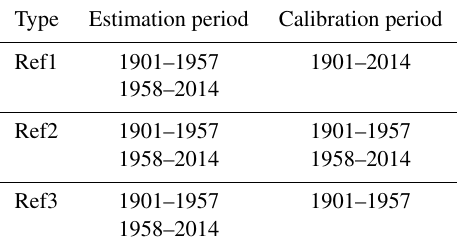
Table 1. Classification of dry status in this study (modified from Mckee et al., 1993).